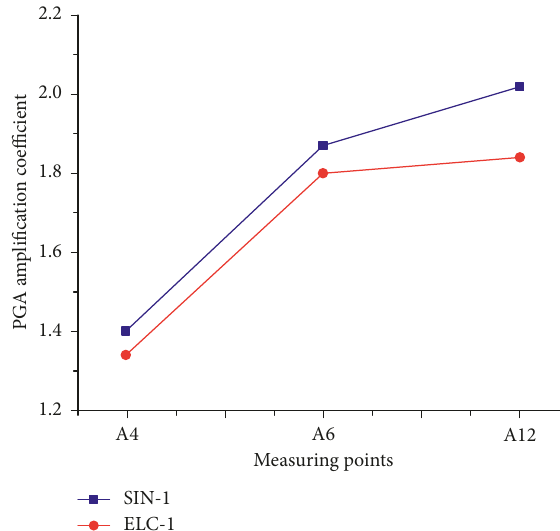
Figure 16: Comparison of PGA amplification coefficients under varying seismic waves.